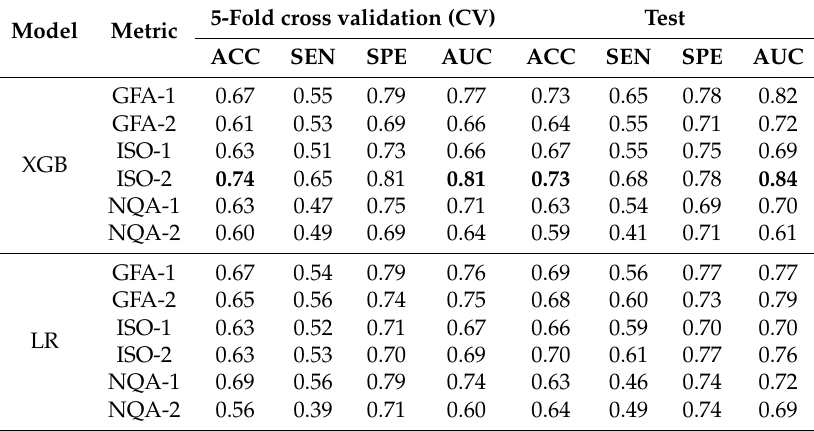
Table 2. The results of identifying ideation subjects from healthy control (HC) subjects and depression subjects by extreme gradient boosting (XGB) and logistic regression (LR) are the average of a 10-time train_test_split iteration. The data of HCs and depression subjects was split into two halves ( − 1 and − 2) to reduce imbalance. ACC, accuracy; AUC, area under curve; SEN, sensitivity; SPE,